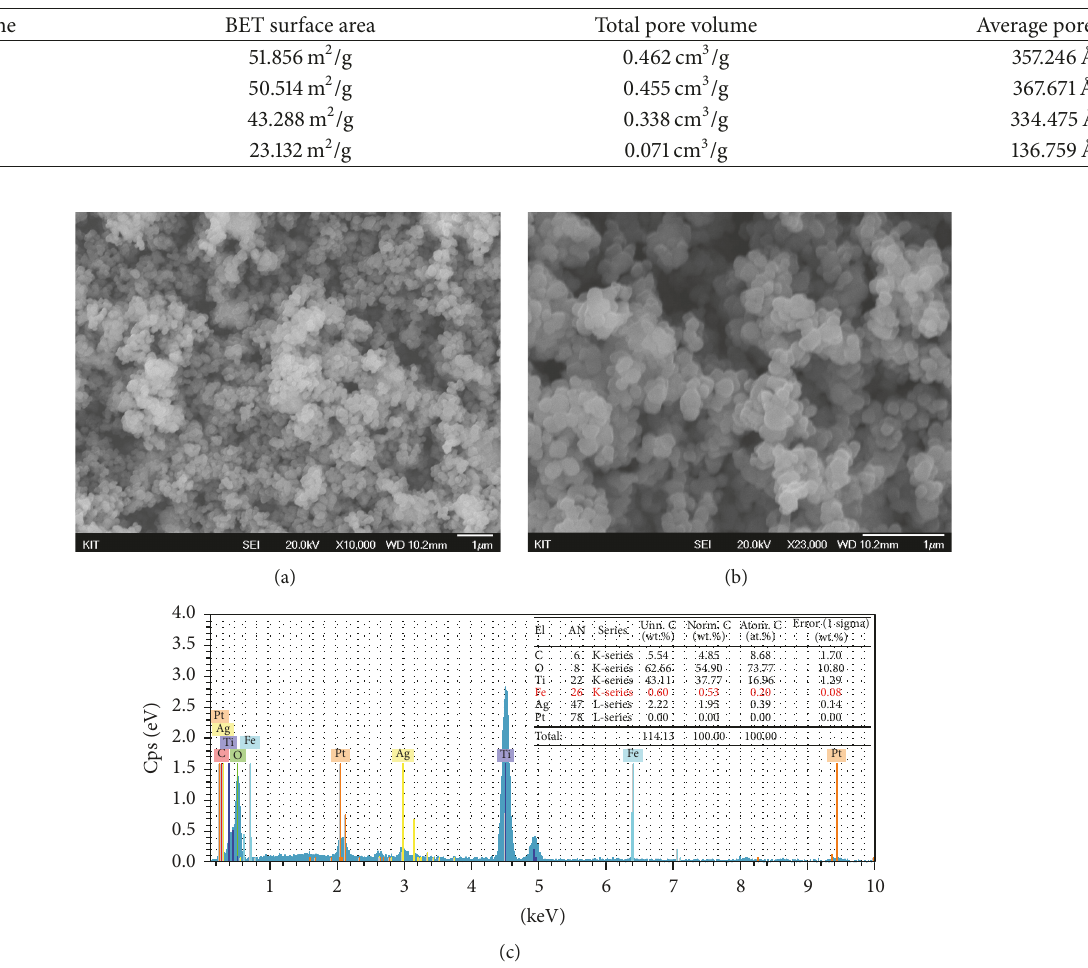
Figure 4: FESEM images of Fe doped TiO 2 (a) low magnification and (b) high magnification and (c) EDS spectrum table of the Fe doped TiO 2